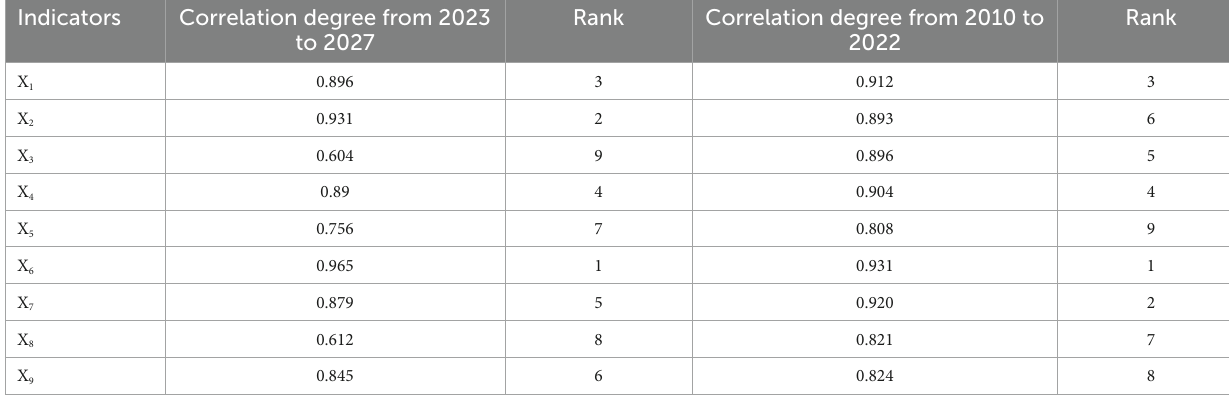
TABLE 8 Gray correlation degree between the demand for cold chain and indicators.